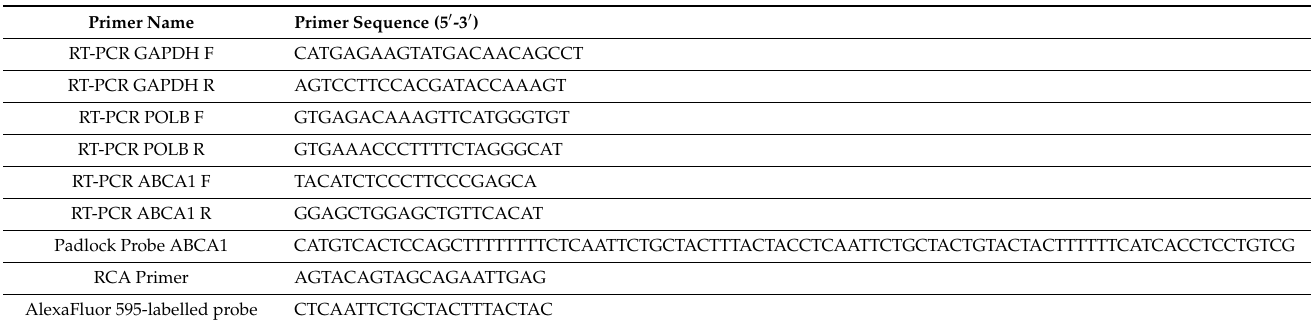
Table 1. Oligos used in the